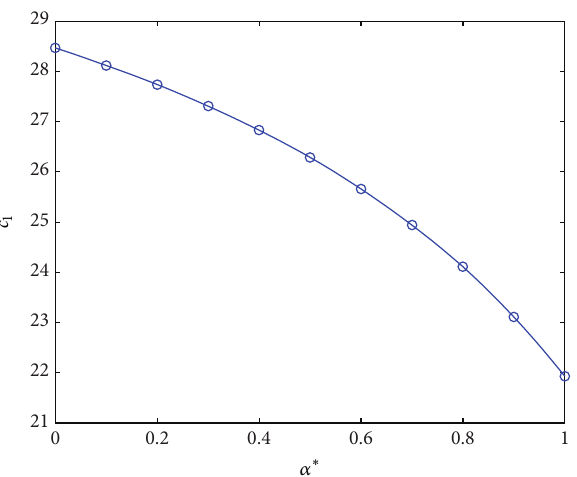
Figure 2: The curve of 𝑐 1 along with 𝛼 ∗